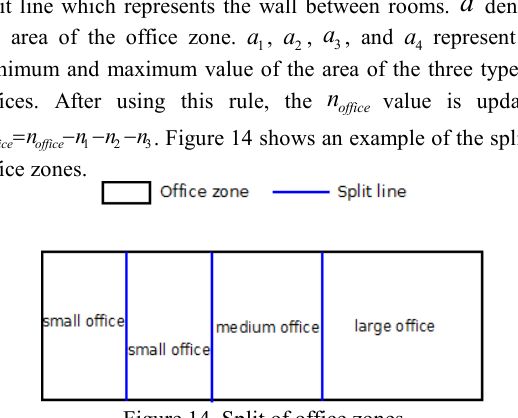
Figure 14. Split of office zones